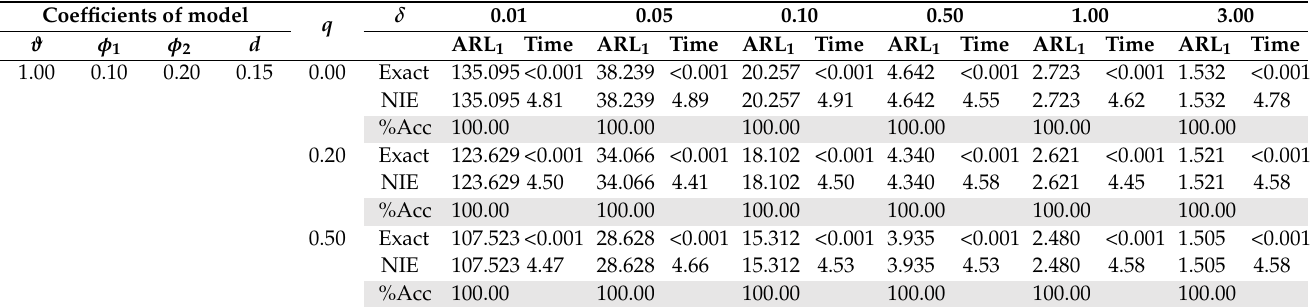
Table 6. The ARL 1 results using the exact formula and the numerical IE technique for ARFI(2, d ) processes running on the modified EWMA control chart with λ =